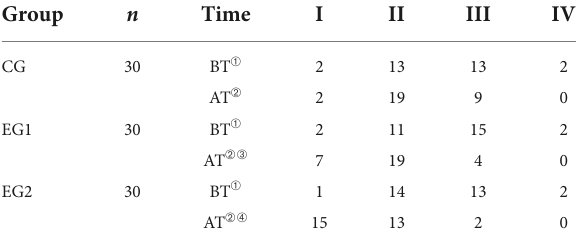
TABLE 6 Electroencephalogram (EEG) grading scores of the patients in the three groups ( ¯ x ± s, control group n = 30, experimental group 1 n = 30, experimental group 2 n = 30).